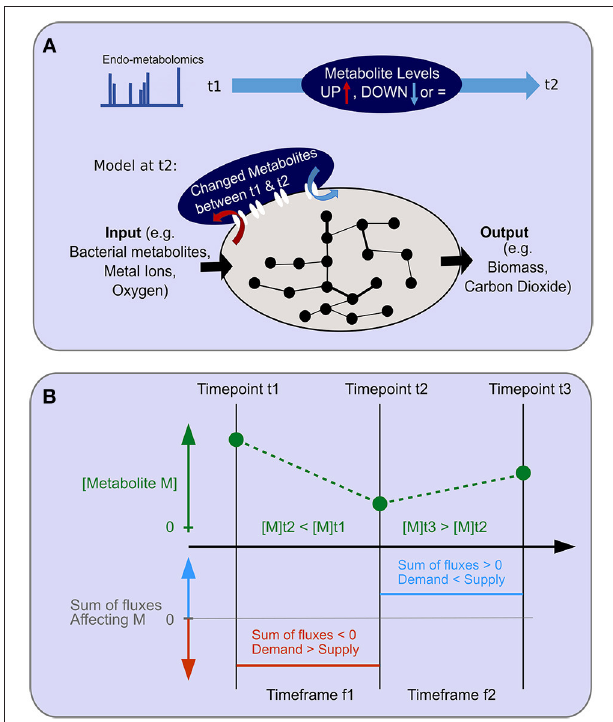
FIGURE 5 | Objective function for endo-metabolomics inclusion. (A) A schematic of the objective function for endo-metabolomics inclusion into FBA is shown. Endo-metabolomics metabolite levels are obtained for each time point. Between each pair of consecutive time points (illustrated as t1 and t2), a statistical test reveals for each metabolite whether the level has increased (UP) or decreased (DOWN) between those two points. The integration of this information with the model uses the transcriptomics constraints from the second time point (t2) as an imation for the time frame (t1–t2) and adds a new system boundary as an additional objective function to reflect the changes in metabolite levels either as inputs or outputs to the system. (B) The relationship between metabolite level changes between consecutive time points and the assumed flux over the time frame is illustrated. An example of two consecutive level changes are shown for the hypothetical metabolite M which has a level decrease between time points t1 and t2, and a level increase between time points t2 and t3. During the time frame f1 for the duration between time points t1 and t2, demand exceeds supply. During the time frame f2 for the duration between time points t2 and t3, supply exceeds